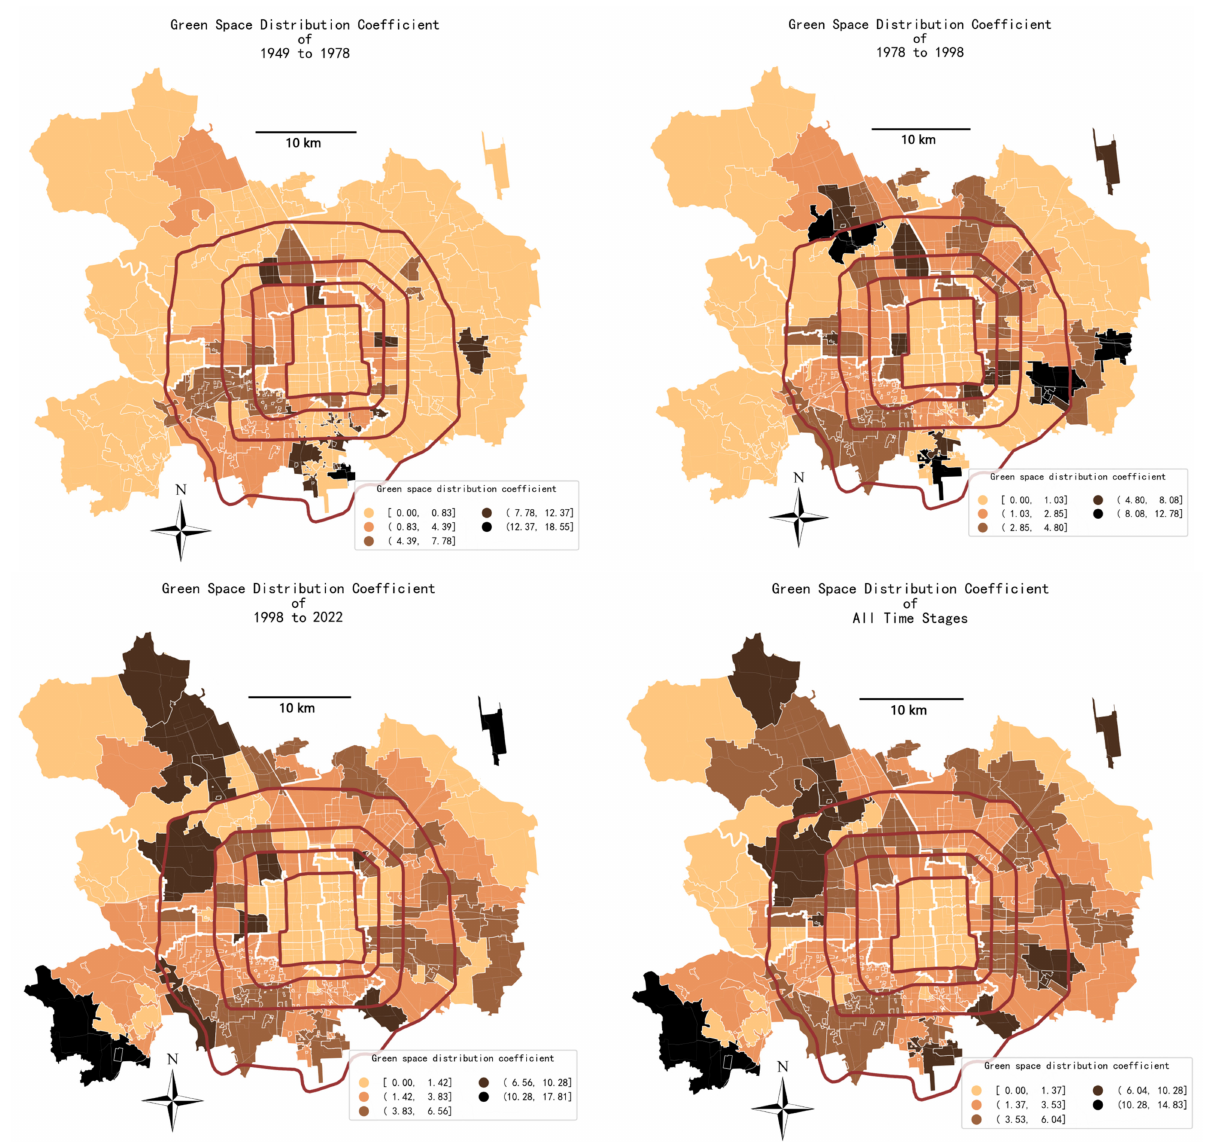
Figure 15. The spatial-temporal pattern of the Green Space Distribution Coefficient